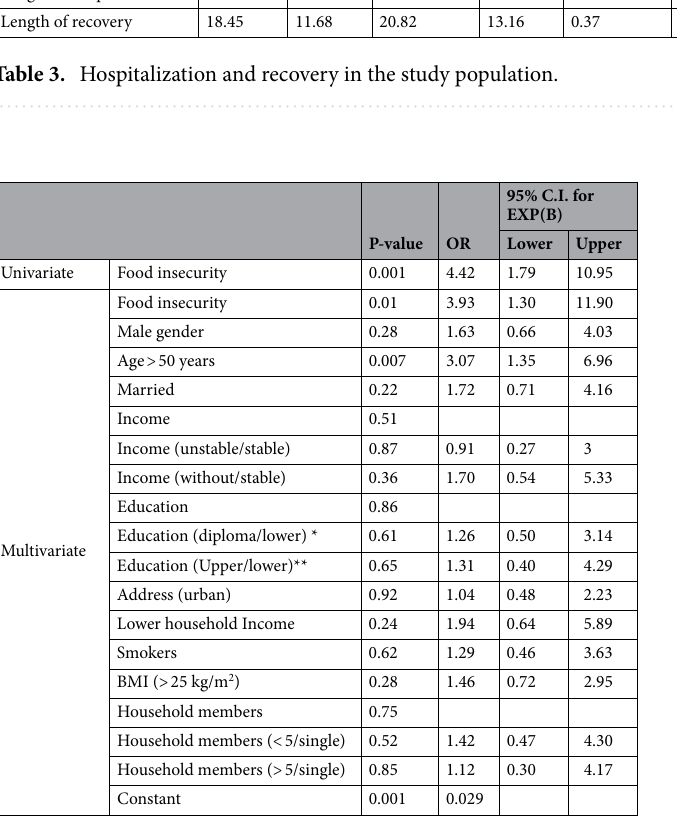
Table 4. Effect of food insecurity on hospitalization with the uni- and multivariate logistic regression. BMI; Body mass index. *Less Than High School’s Diploma versus High School’s Diploma. **High School’s Diploma versus Bachelor’s Degree and